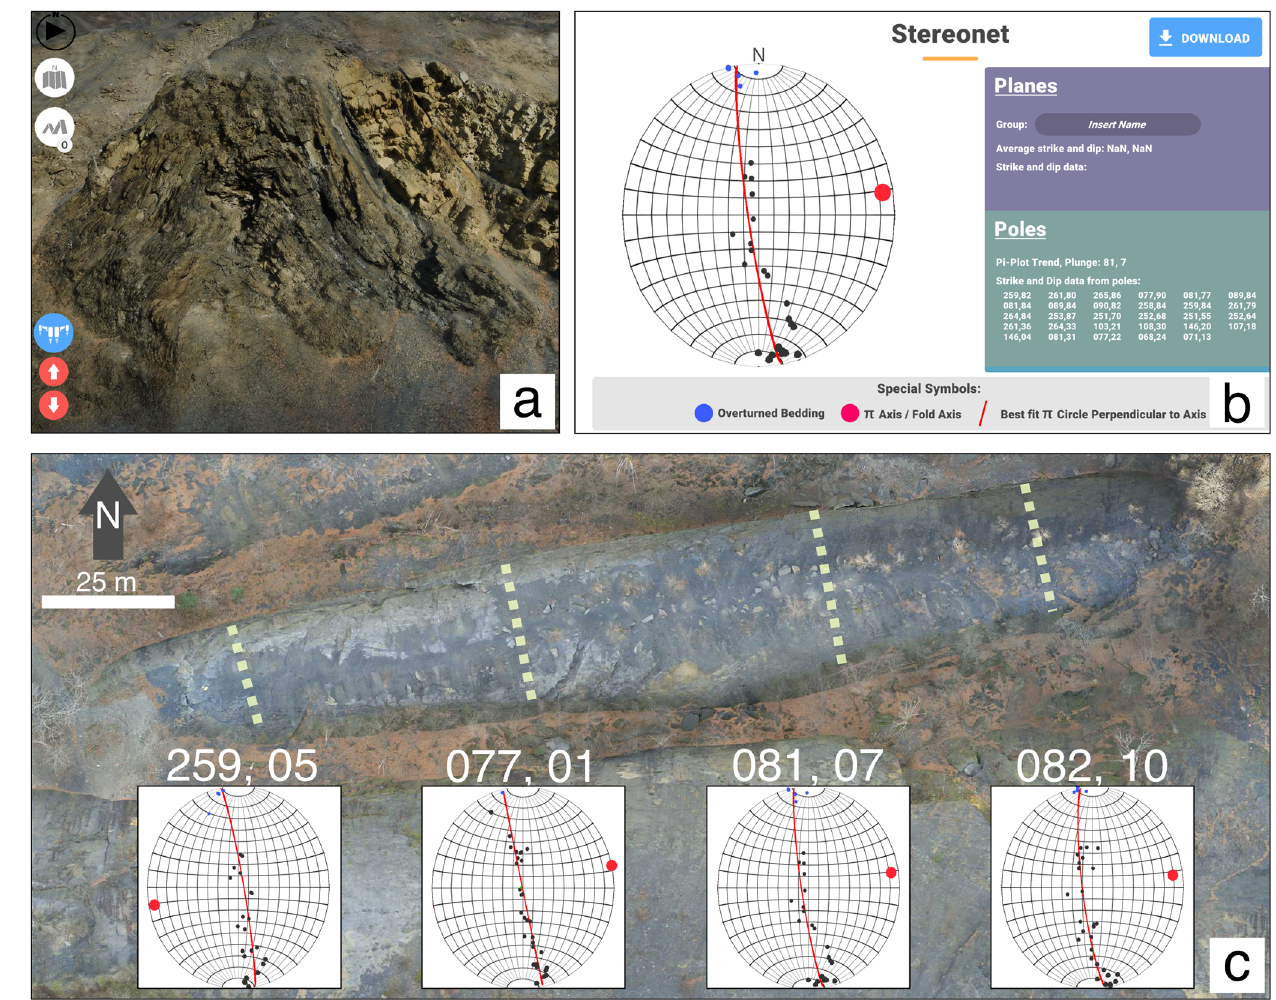
Figure 2. Examples of exercises and data. (a) An anticline (and, often, the adjacent syncline) exposed in profile in the eastern wall of the strip mine was a common feature that the students selected for description. The field of view is 55m wide. (b) A screenshot of data from a scan line used to determine the trend and plunge of the fold axis of the Whaleback in the central eastern quarter. The fold axis orientation, generated from an automatic pi plot feature, is exaggerated as a red circle; the data for each measurement are printed on the right. (c) Students annotated an orthophoto of the Whaleback with stereonet data to investigate variations in the fold axis and best characterize the fold geometry. Each stereonet is associated with a student-made scan line (shown as a dashed line) on a section of the fold, with the trend and plunge values of the calculated fold axis printed